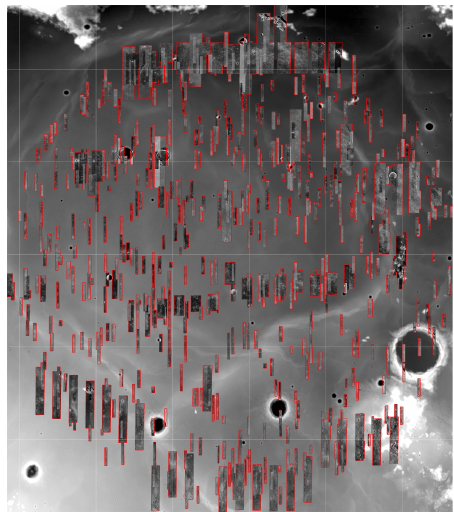
Figure 8. Distribution of NAC images used for “ground truth” in calibrating the WAC instrument. The NAC observations are overlaid on the WAC derived topographic model, GLD100 [Scholten et al.,